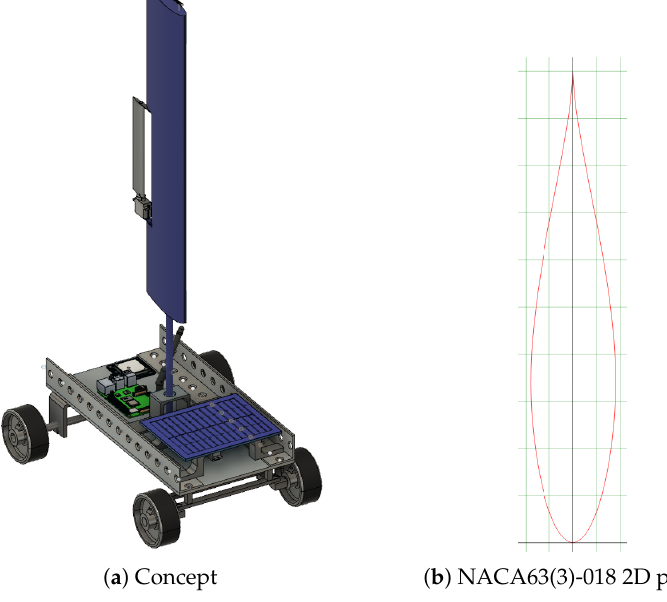
Figure 1. Land yacht